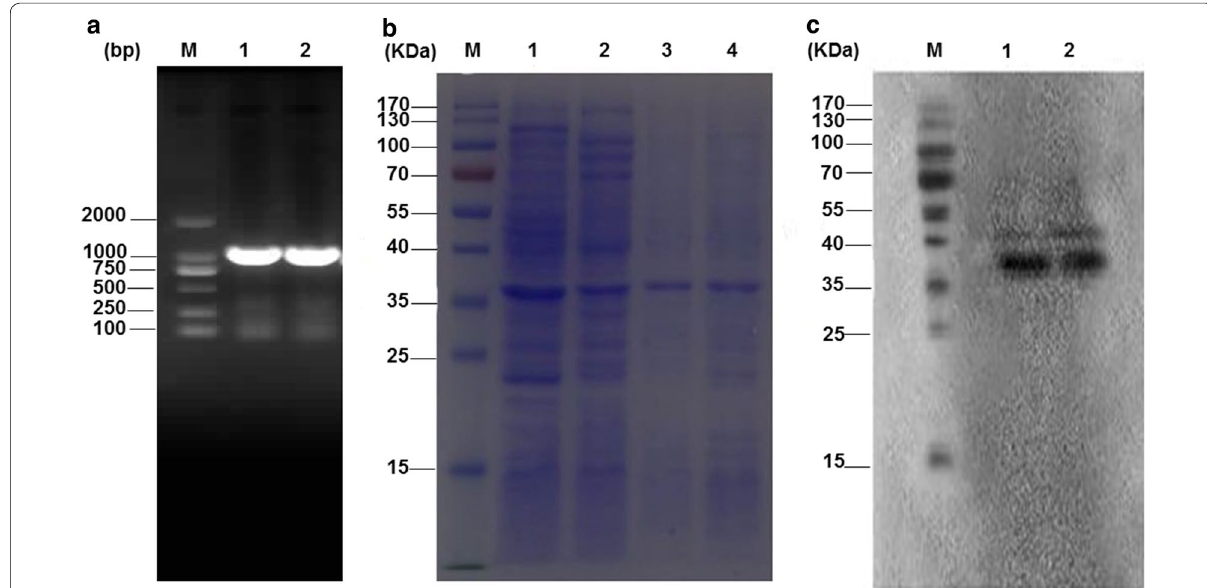
Fig. 1 Cloning, expression and purification of the PEDV spike protein. a PCR amplification of the truncated spike gene of PEDV corresponding to the 1330–2310 bp of the spike protein gene (444–770 amino acids). Lanes 1–2, PCR amplification products of the PEDV spike gene. b SDS-PAGE analysis of the expression and purification of the PEDV spike protein. Lanes 1–2, the supernatant of E. coli cell lysate that were transformed with the PEDV spike protein gene after induction. Lanes 3–4, PEDV spike protein eluted from Ni–NTA Agarose. c Western blot analysis of the PEDV spike protein with an anti-6 His antibody. Lanes 1–2, the purified PEDV spike protein. Lane M, molecular weight ×